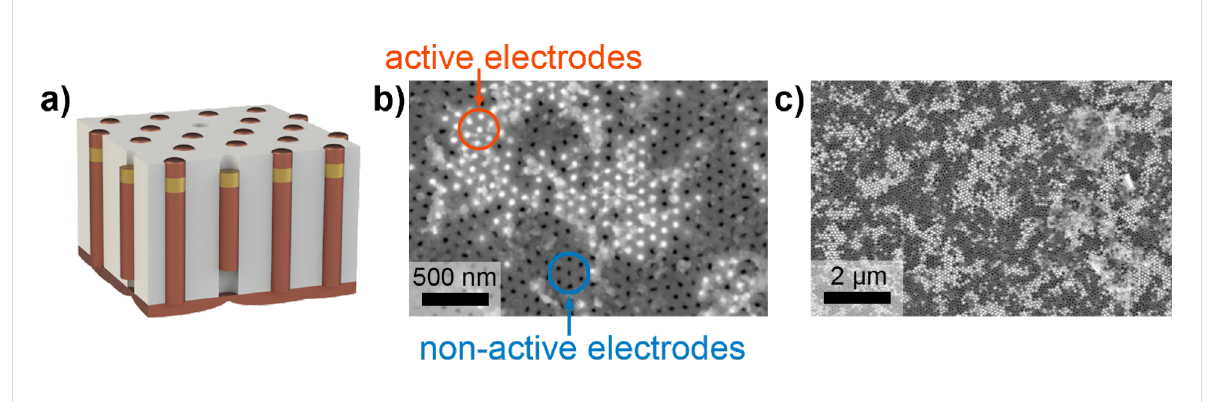
Figure 3: An NEA after Cu re-deposition onto recessed Au electrodes: 3D schematic drawing (a) and top-view SEM images recorded at high (b) and low (c) magnification.